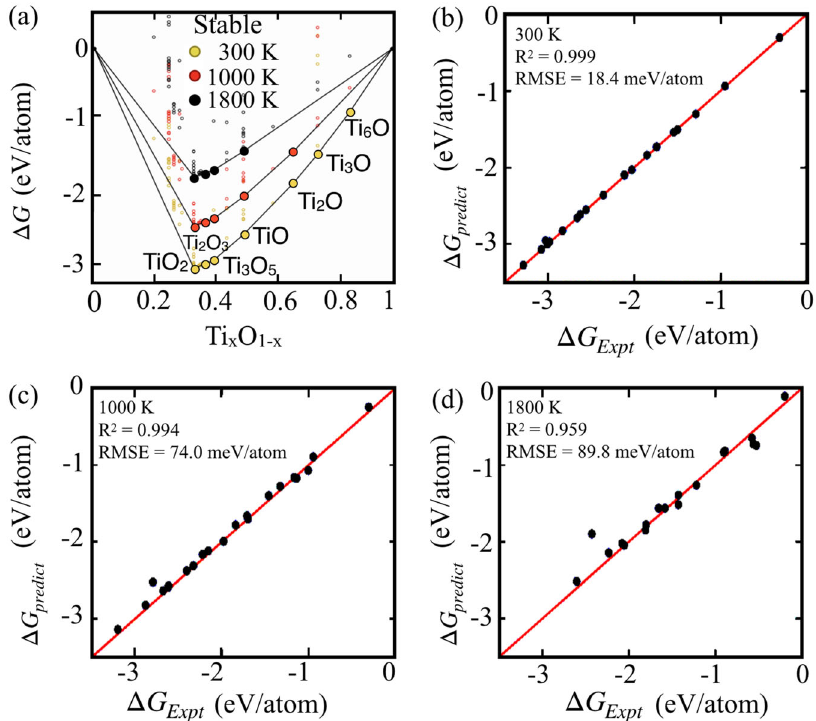
Fig. 1 Validation of Ti-O phase stability. a Convex hull of Ti 1 – x O x generated using SISSO model, and ( b – d ) corresponding error in prediction compared to experimental (NIST-JANAF) dataset at 300, 1000, and 1800 K. The error in prediction increases with temperature due to use of 0 K unit cell